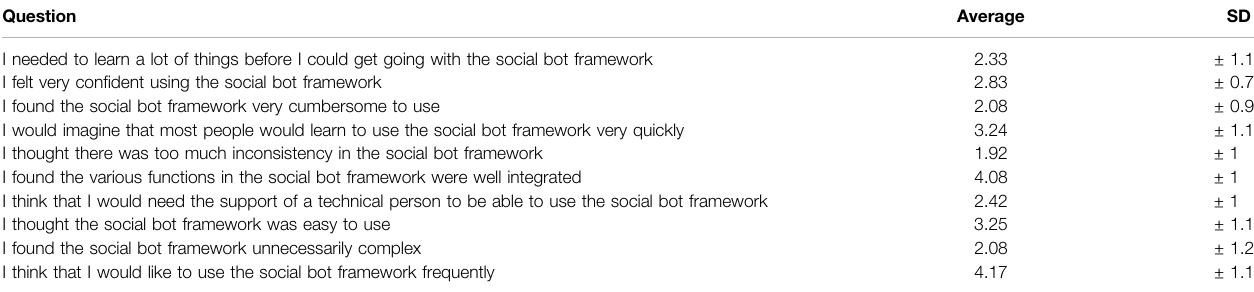
TABLE 1 | Results of the usability questionnaire. Answers were provided in ordinal scale where 1 a “ strongly disagree ” and 5 a “ strongly agree ” ( n (cid:1)